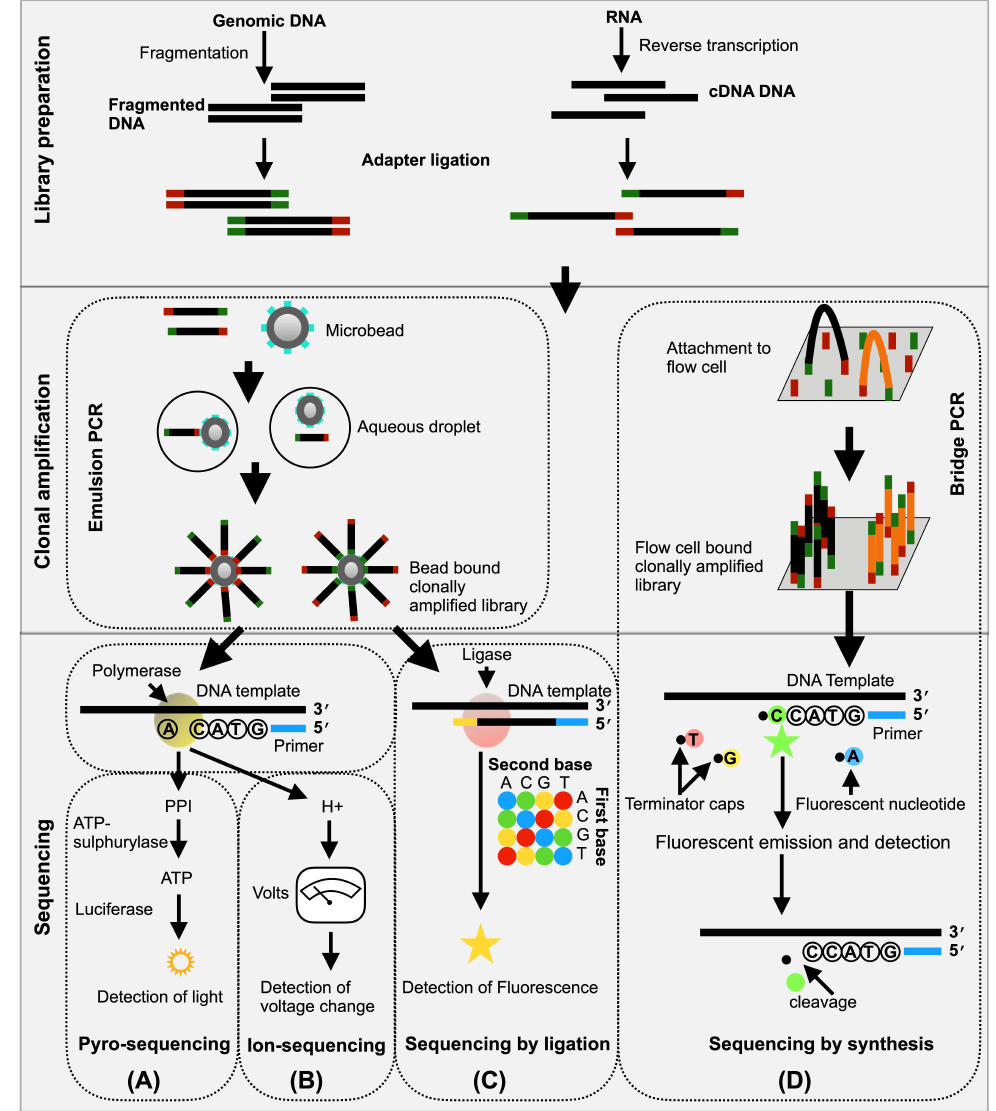
Figure 3. Overview of next-generation sequencing. Clonally amplified template DNA bound to beads are sequenced by either pyrosequencing ( A ), ion-sequencing ( B ) or ligation ( C ), while clonally amplified templates bound to glass flow cells are sequenced by the synthesis technique. All of the NGS techniques include three main steps: (i) Library preparation; (ii) clonal amplification; and, (iii) sequencing. The library to be sequenced is prepared either by fragmenting genomic DNA, or by reverse transcribing the RNA into cDNA (hereafter referred to as DNA). An adapter sequence is added to either side of the DNA which permits the hybridization of the library to the sequencing chips and provides a universal primer binding site for the sequencing primers. In ( A ), ( B ), and ( C ), the library fragment is amplified on solid surface beads by emulsion PCR using covalently attached DNA linkers that hybridize to the library adapters. The sequence of each cluster is optically read either through the generation of light during the polymerase reaction (as in A ), or change in the voltage due to the release of H ion during the addition of a nucleotide (as in B ) or by fluorescent signal during ligation (as in C ), from repeated cycles of nucleotide incorporation. In ( D ), a library fragment is bound to an optically transparent glass flow cell with covalently attached DNA linkers that hybridize the library adapters by bridge PCR. The chip bound clusters’ sequences can be acquired by the detection of the fluorescence of the reversible-terminator nucleotides at the end of the proceeding extension